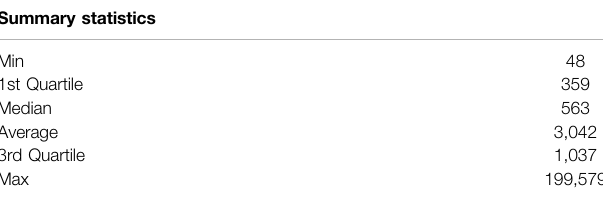
TABLE 1 | Summary Statistics of the